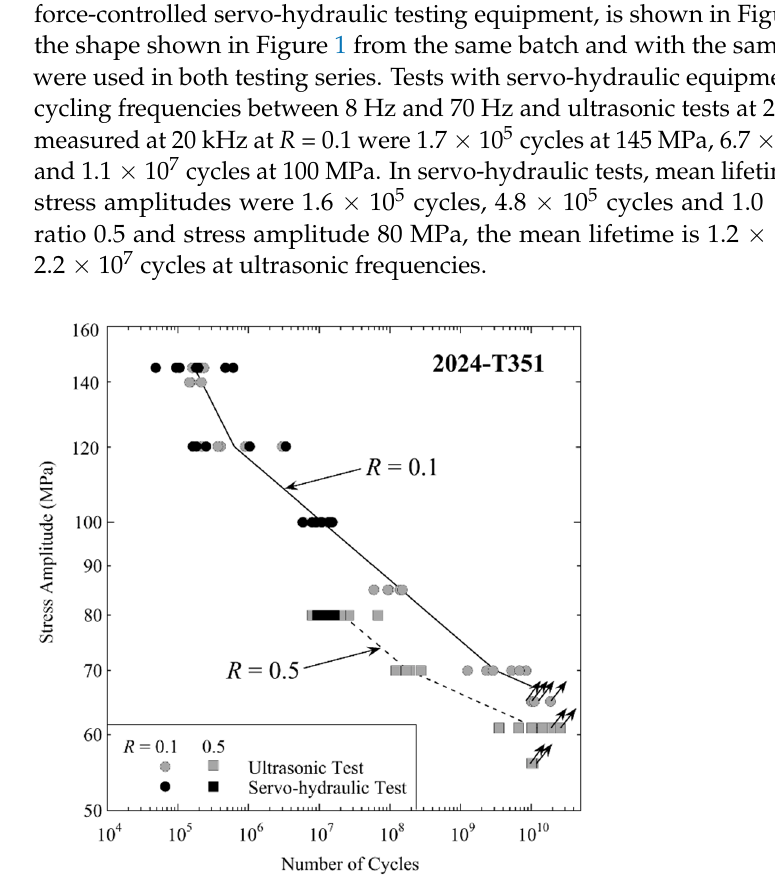
Figure 2. Fatigue data of aluminium alloy 2024-T351 measured at load ratio R = 0.1 (circles) and R = 0.5 (squares) with servo-hydraulic equipment at cycling frequencies between 8 Hz and 70 Hz (black symbols) and with ultrasonic equipment at 20 kHz (grey symbols).